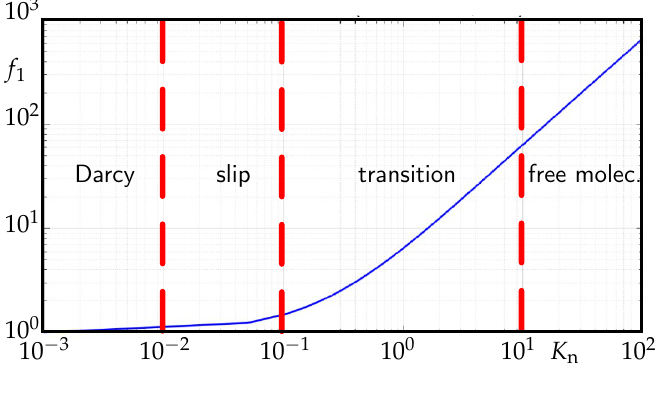
Figure 5. Permeability correction factor f 1 plotted against the Knudesen number K n for methane ( T = 191 K, k 0 = 1 × 10 − 10 m 2 , φ = 0.1) with flow